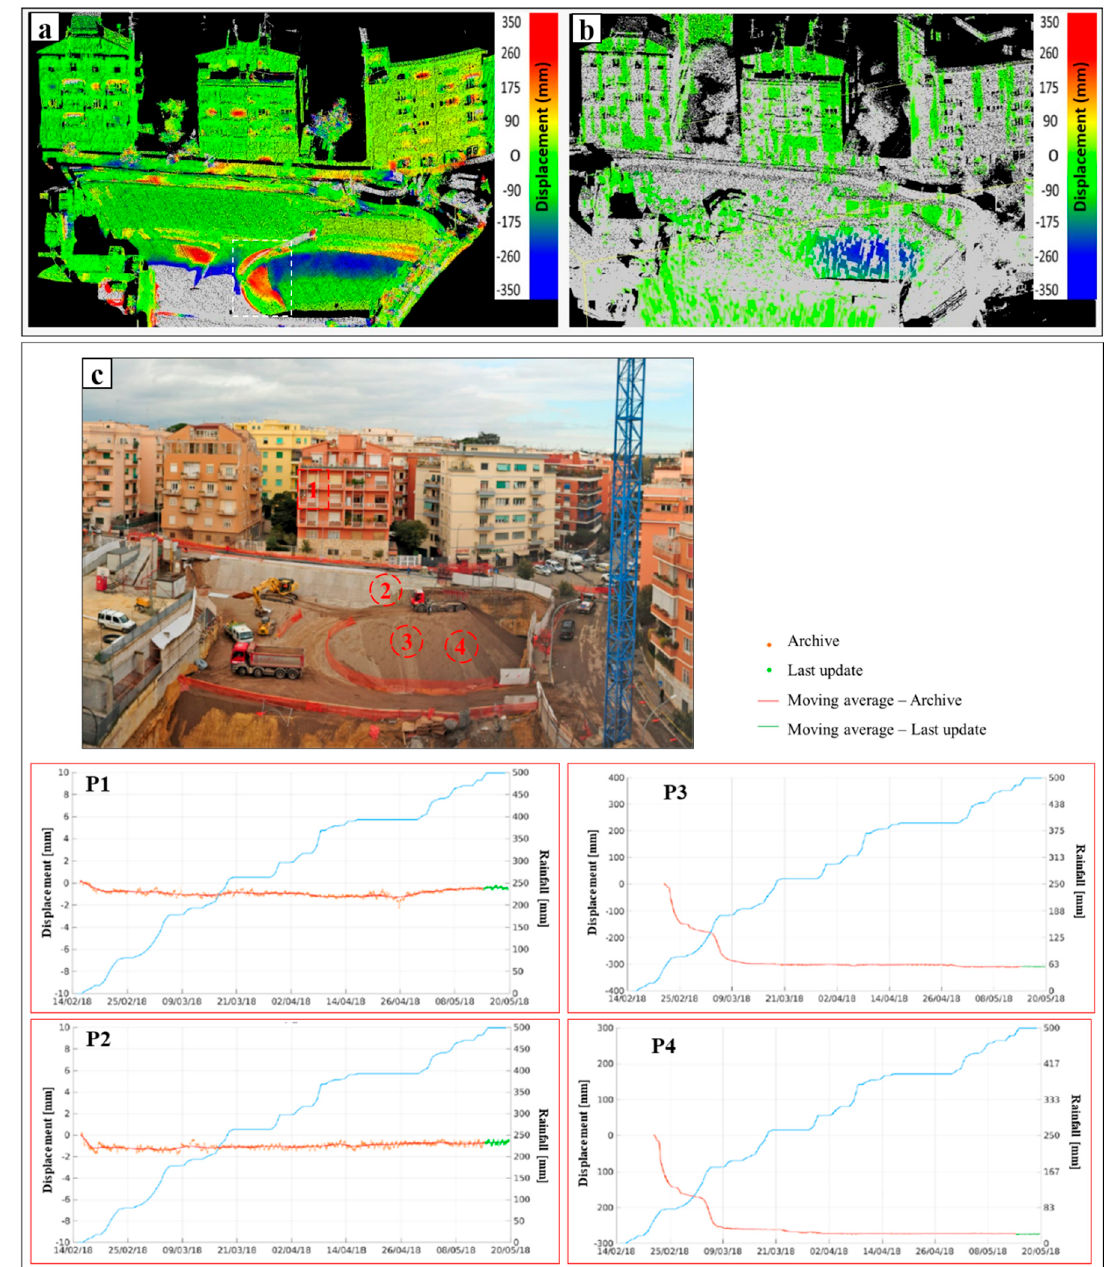
Figure 6. ( a ) 3D distance map, in terms of M3C2 distance, obtained through the comparison between point clouds acquired on February 19th and May 26th, 2018, white dashed polygon indicates lack of material detected only by terrestrial laser scanner (TLS) analysis; ( b ) radar displacement map referred to the period between February 22nd and March 5th (cumulative), projected on the point cloud acquired on March 2nd; ( c ) view of the entire construction site, red polygons indicate the main areas of interest: pixel related to the building behind the construction site (P1), pixel related to a section of the piling wall (2); pixels related to a portion of filling material. Charts below shown displacement time series of such areas with associated rainfalls. Data relative to the last week of acquisitions (last update) is shown in green.